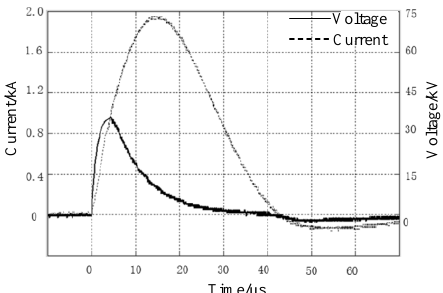
Figure 20. Current and voltage waveform of modified soil with the water content of 10% when injected into the impulse current